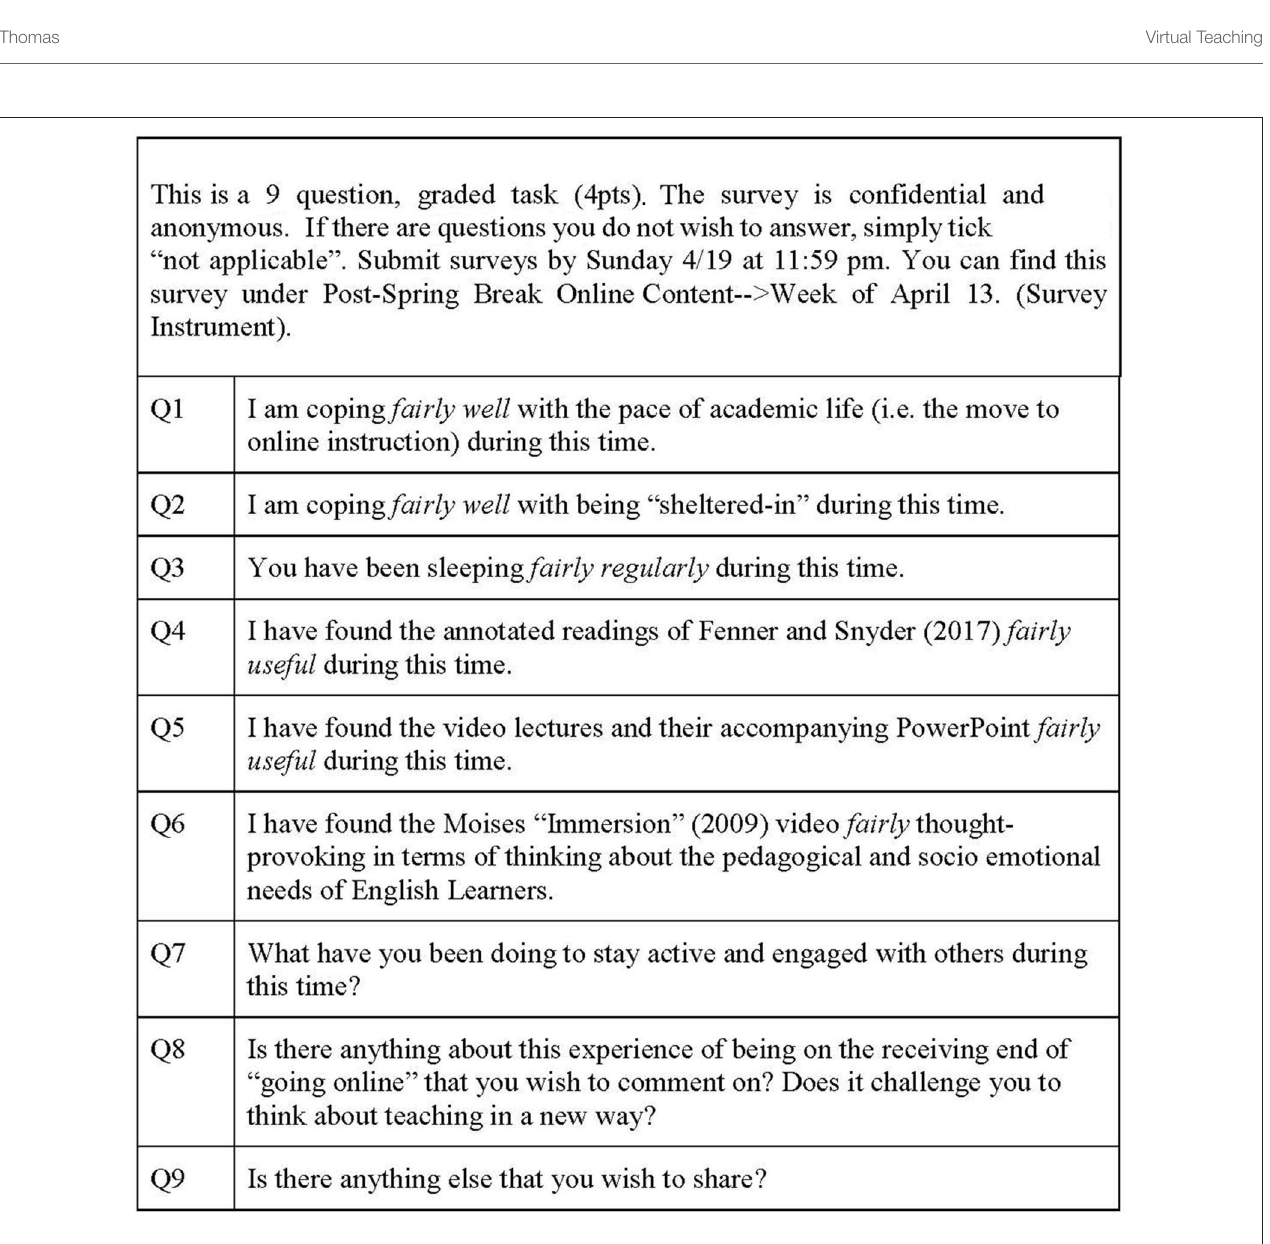
FIGURE 1 | Wellness check and online feedback